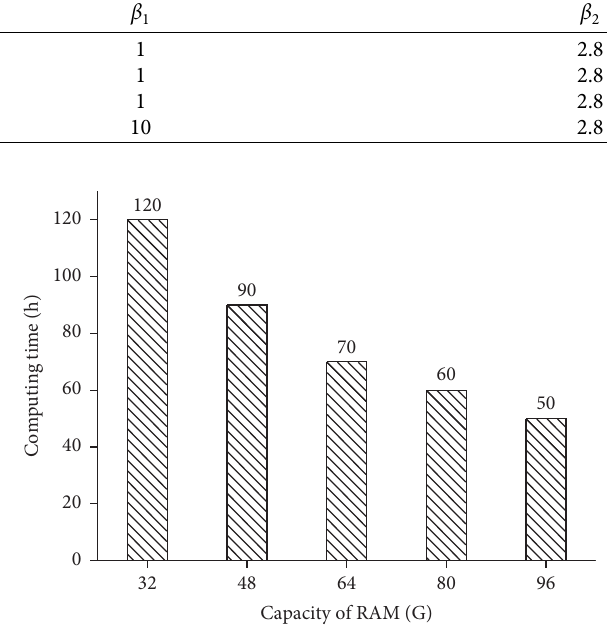
Figure 10: The RM computing time